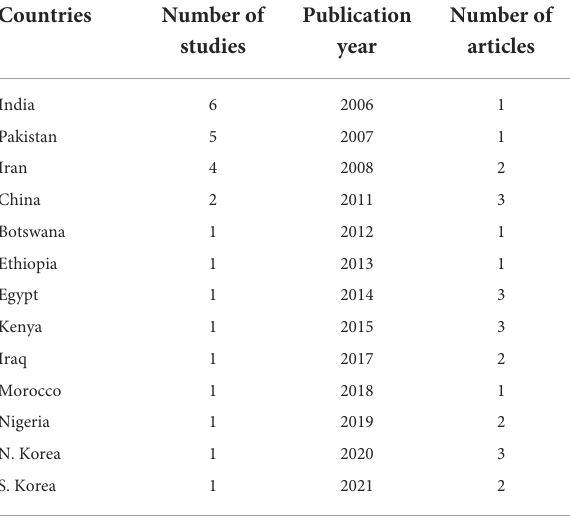
TABLE 1 The number of studies by geographical location and years of publication. Countries Number of